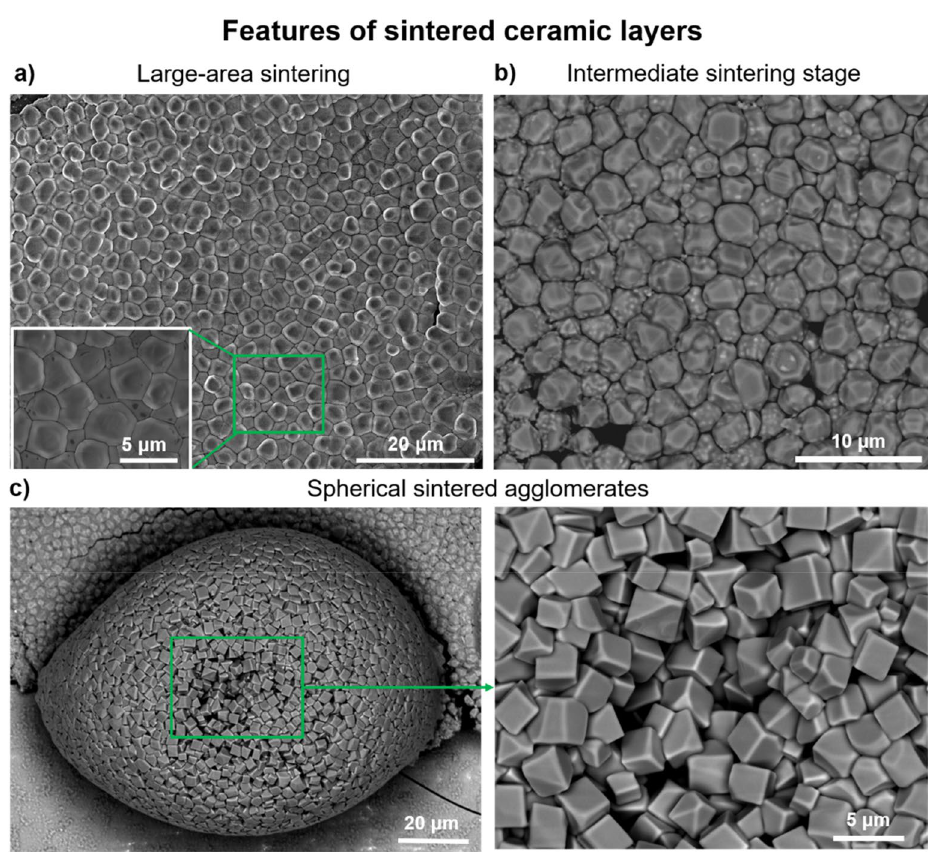
Figure 5. Morphological features and irregularities observed on FLA processed ceramic films. ( a ) SEM top view image of sintered film area (120 µm × 120 µm), inset reveals sintered grains of the layer. ( b ) SEM image of the area appearing in the intermediate sintering state (initiation of the grain growth). ( c ) SEM images of sintered sphere at different magnifications (spheres are located at the border of the sintered